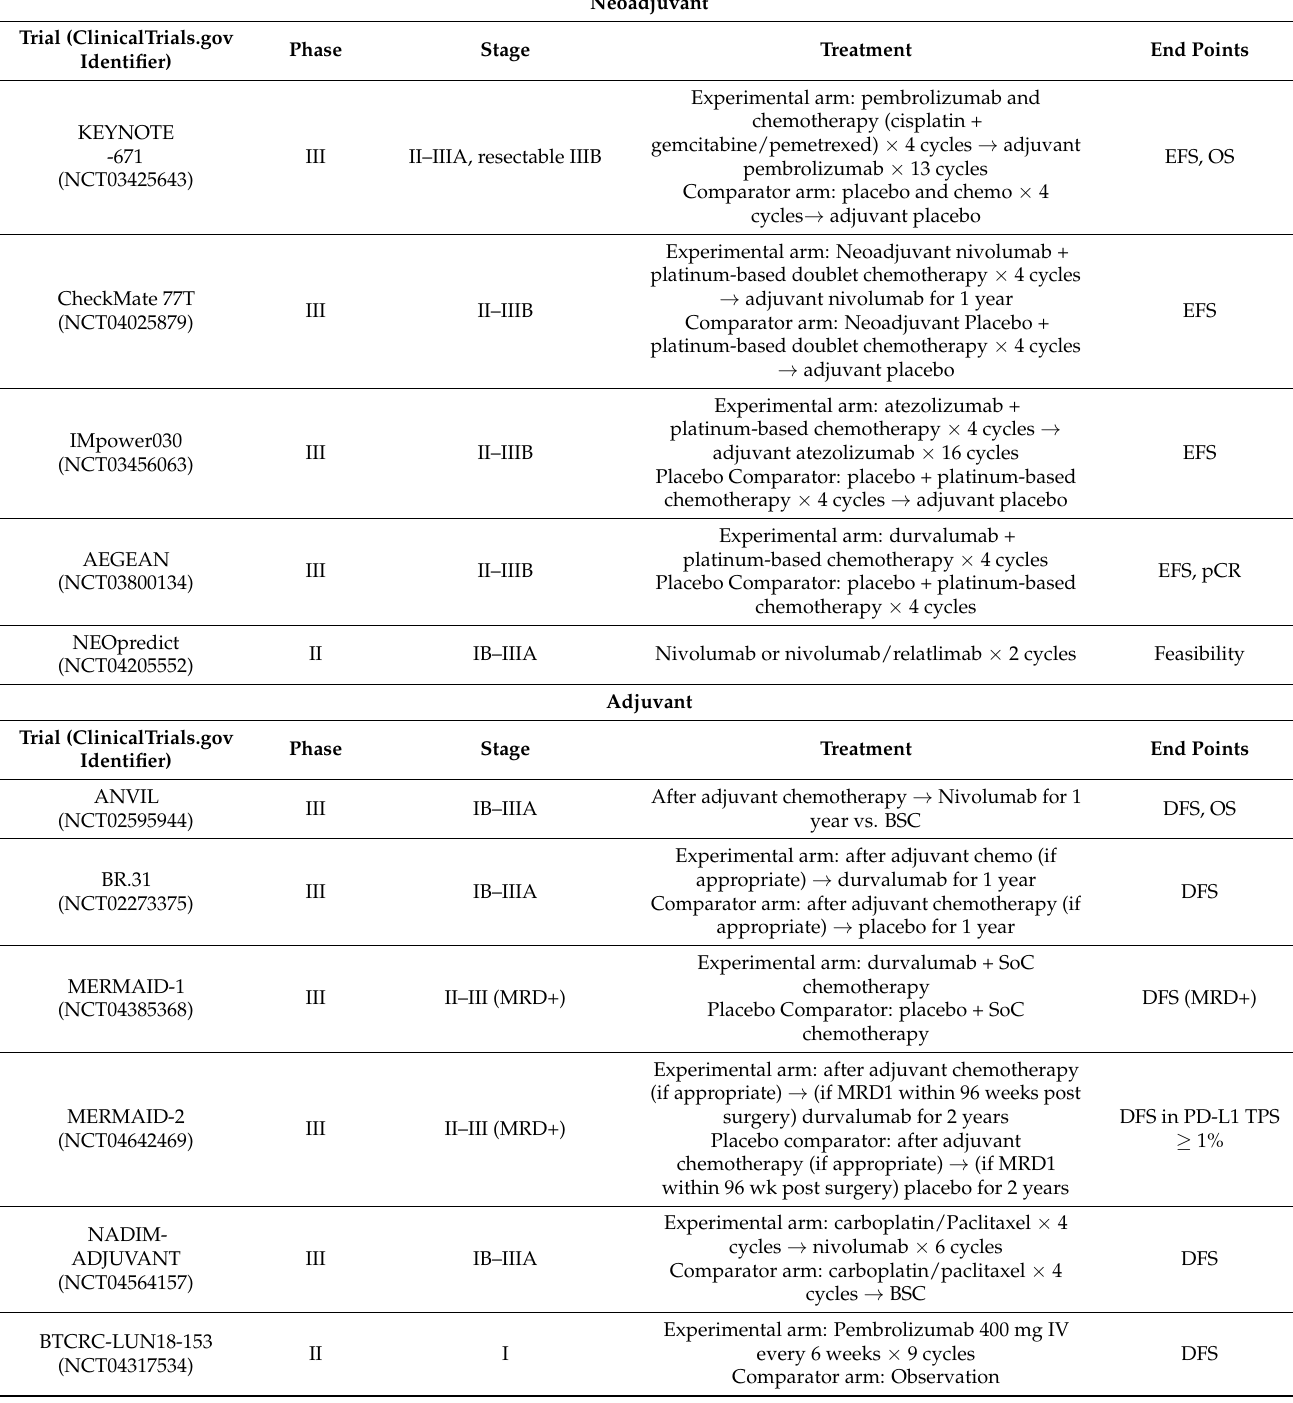
Table 3. Current ongoing clinical trials exploring the role of neoadjuvant or adjuvant ICIs in NSCLC